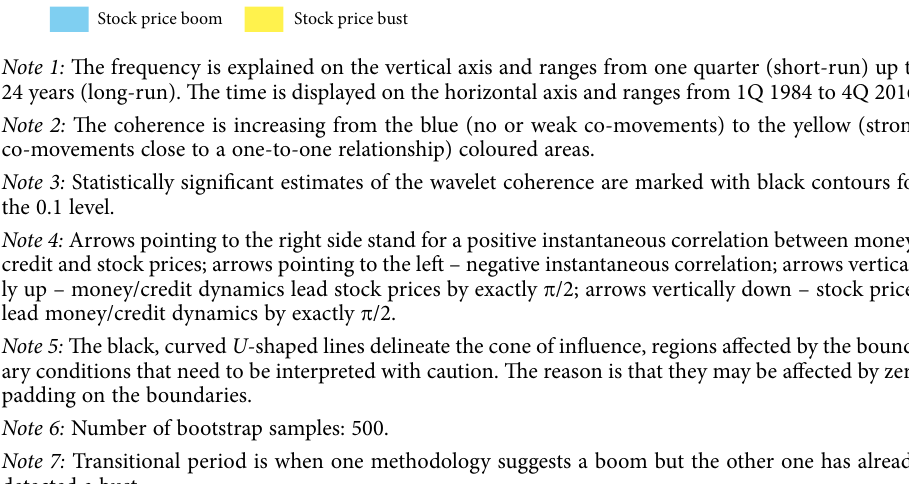
Figure 1. Wavelet coherence between: a – M3 and stock prices; b – bank credit and stock prices for the US (source: own